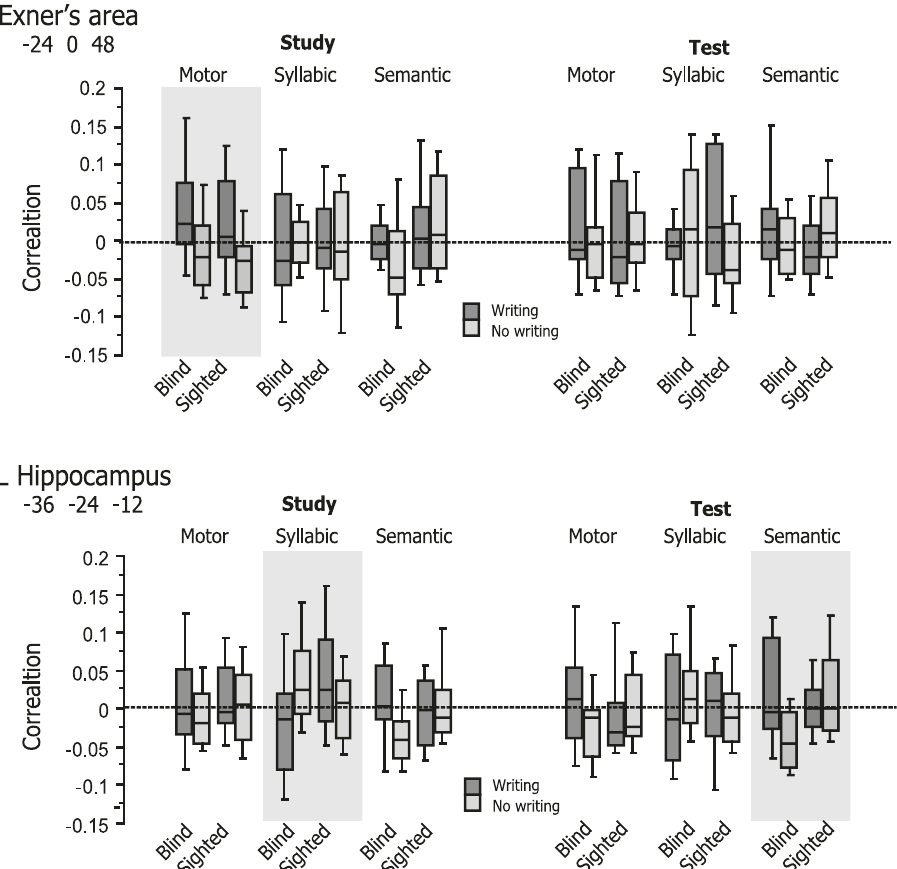
Fig. 4 Correlations with the theoretical RDMs in Exner ’ s area and left hippocampus. During the study period, multi-voxel activation patterns in Exner ’ s area showed a signi fi cant effect of learning condition for the motor RDM ( p = 0.013, shaded in gray). The main effects and their interaction were non- signi fi cant for the three RDMs during the test period ( p > 0.1 for all). On the other hand, the left hippocampus showed signi fi cant crossover interaction with the syllabic RDM ( p = 0.023), suggesting that handwriting yielded a differential impact on activation patterns between the blind and sighted groups. During the test period, the same segment of the left hippocampus showed signi fi cant condition × group interaction for the semantic RDM ( p = 0.026), again suggesting that semantic information was more weakly represented for the blind relative to the sighted